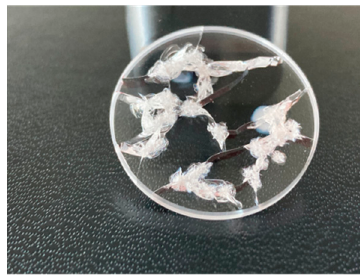
Figure 4. Typical picture of an as-cleaned uncoated sample after laser damage testing.